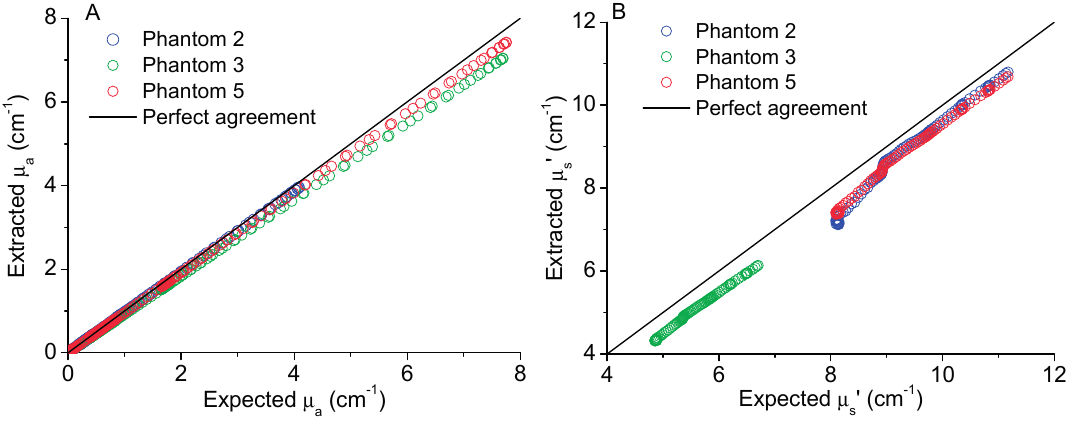
Figure 6. ( A ) Extracted versus expected absorption coefficient (µ a (cm − 1 )) for three of the test phantoms; ( B ) Extracted versus expected reduced scattering coefficient (µ s ’ (cm − 1 )) for three of the test